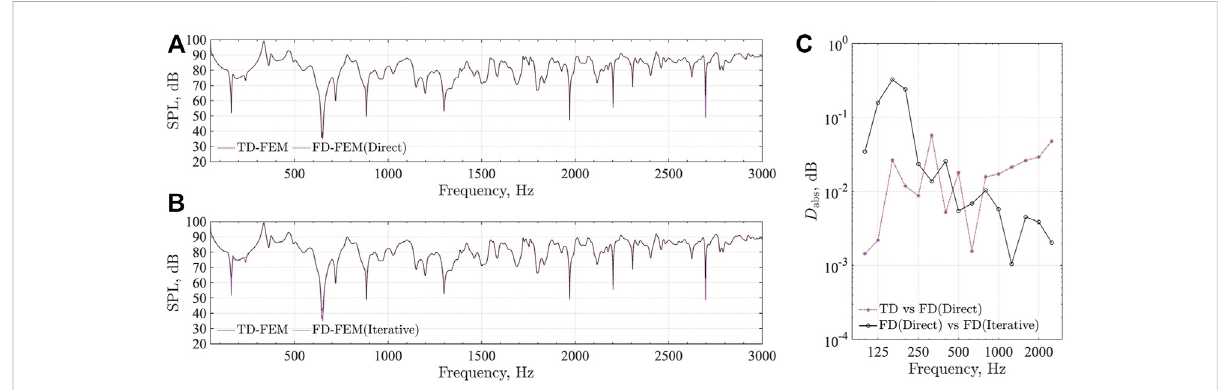
FIGURE 3 Comparison of frequency responses at R1 between TD-FEM and FD-FEM using sparse direct solver and iterative solver, and the absolute difference between them in